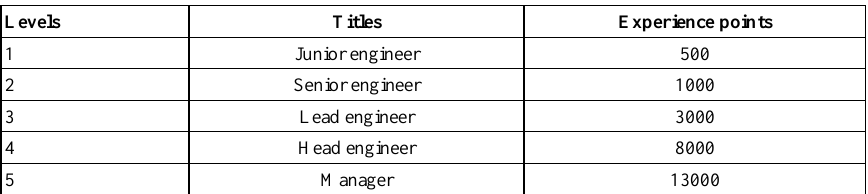
Table 3. Levels and the required experience points